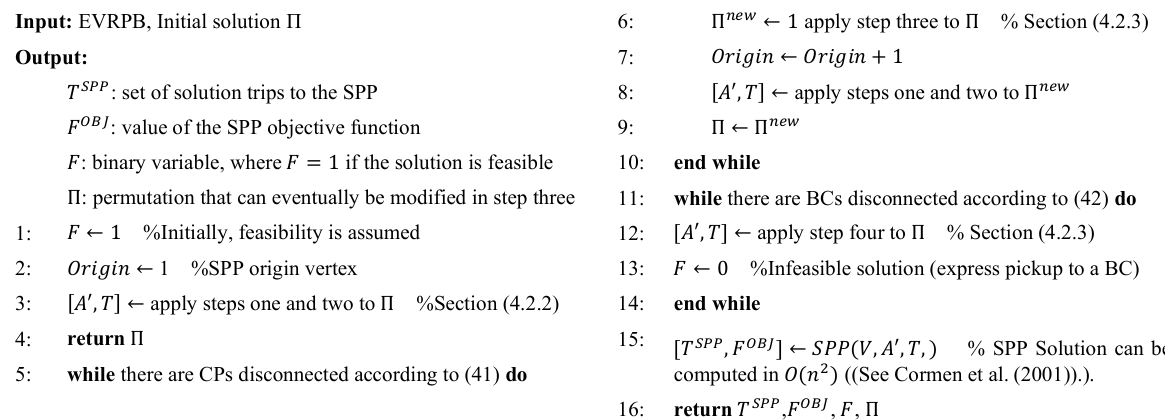
Algorithm 2. OSPB pseudo